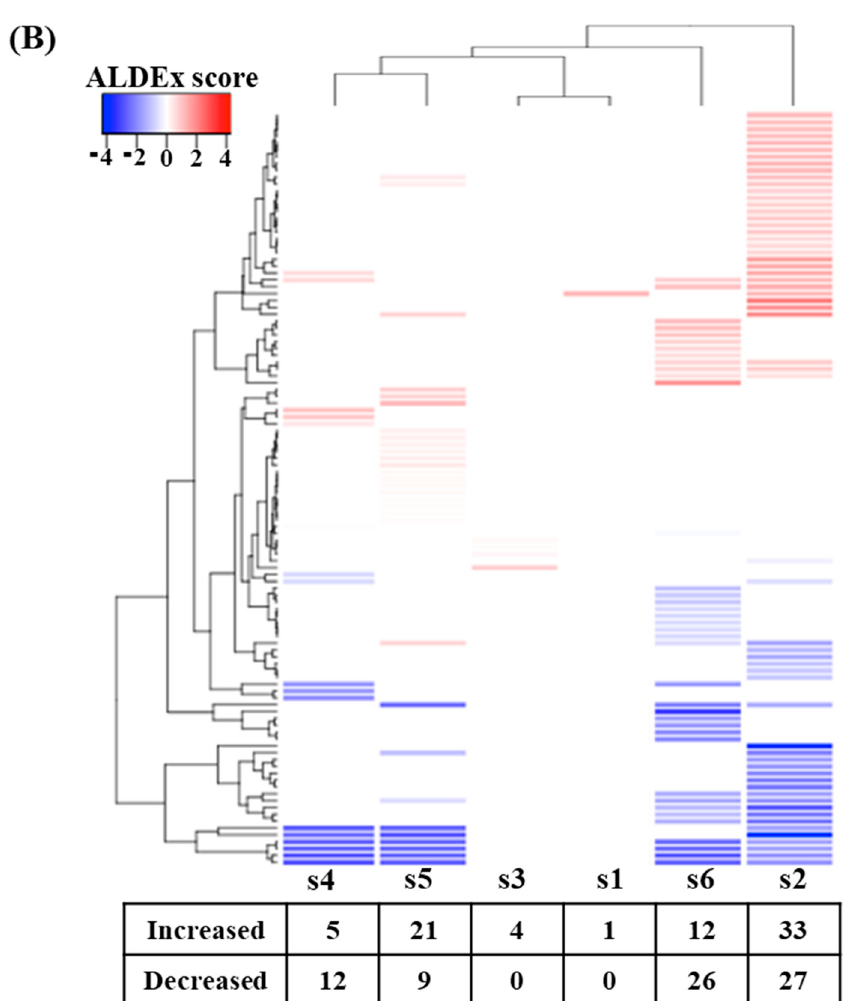
Figure 5. Comparison of PICRUSt-predicted metabolic activities before and after fecal fermentation with digested beef. Principal component analysis (PCA) with red and blue letters indicating subjects before and after fecal fermentation ( A ). The number of differentially abundant metabolic activities after the addition of the digested beef powder ( B ).